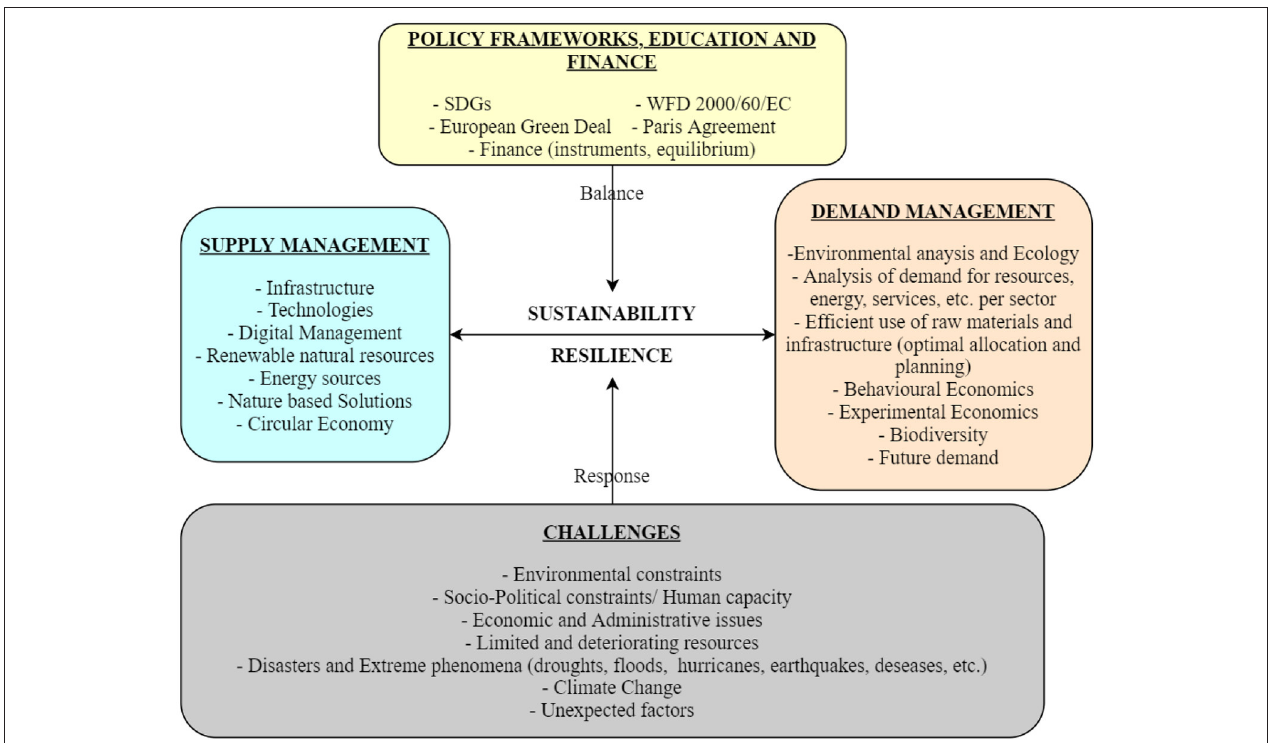
FIGURE 5 | The most common components of the supply and demand sides, which must be balanced to achieve sustainability (environmental, economic, etc.); the challenges that our systems are facing trying to become more resilient. The policy-finance frameworks and education will ensure this managerial approach. towards a more coordinated management and across